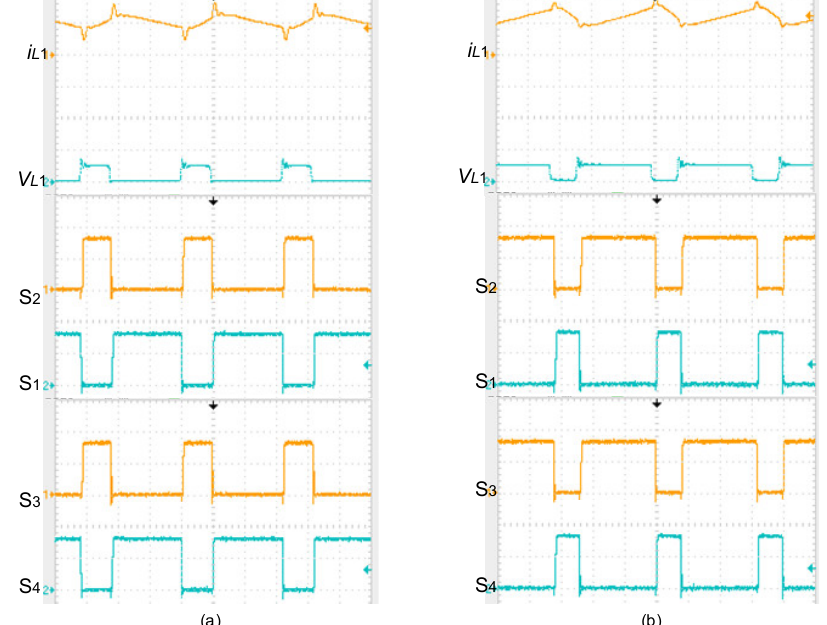
Figure 11. Scope results showing the inductor L 1 current and voltage alongside the associated switching signals of the MOSFETs for operating the multiple input converter in Mode A at ( a ) 30% duty and ( b ) 75% duty.